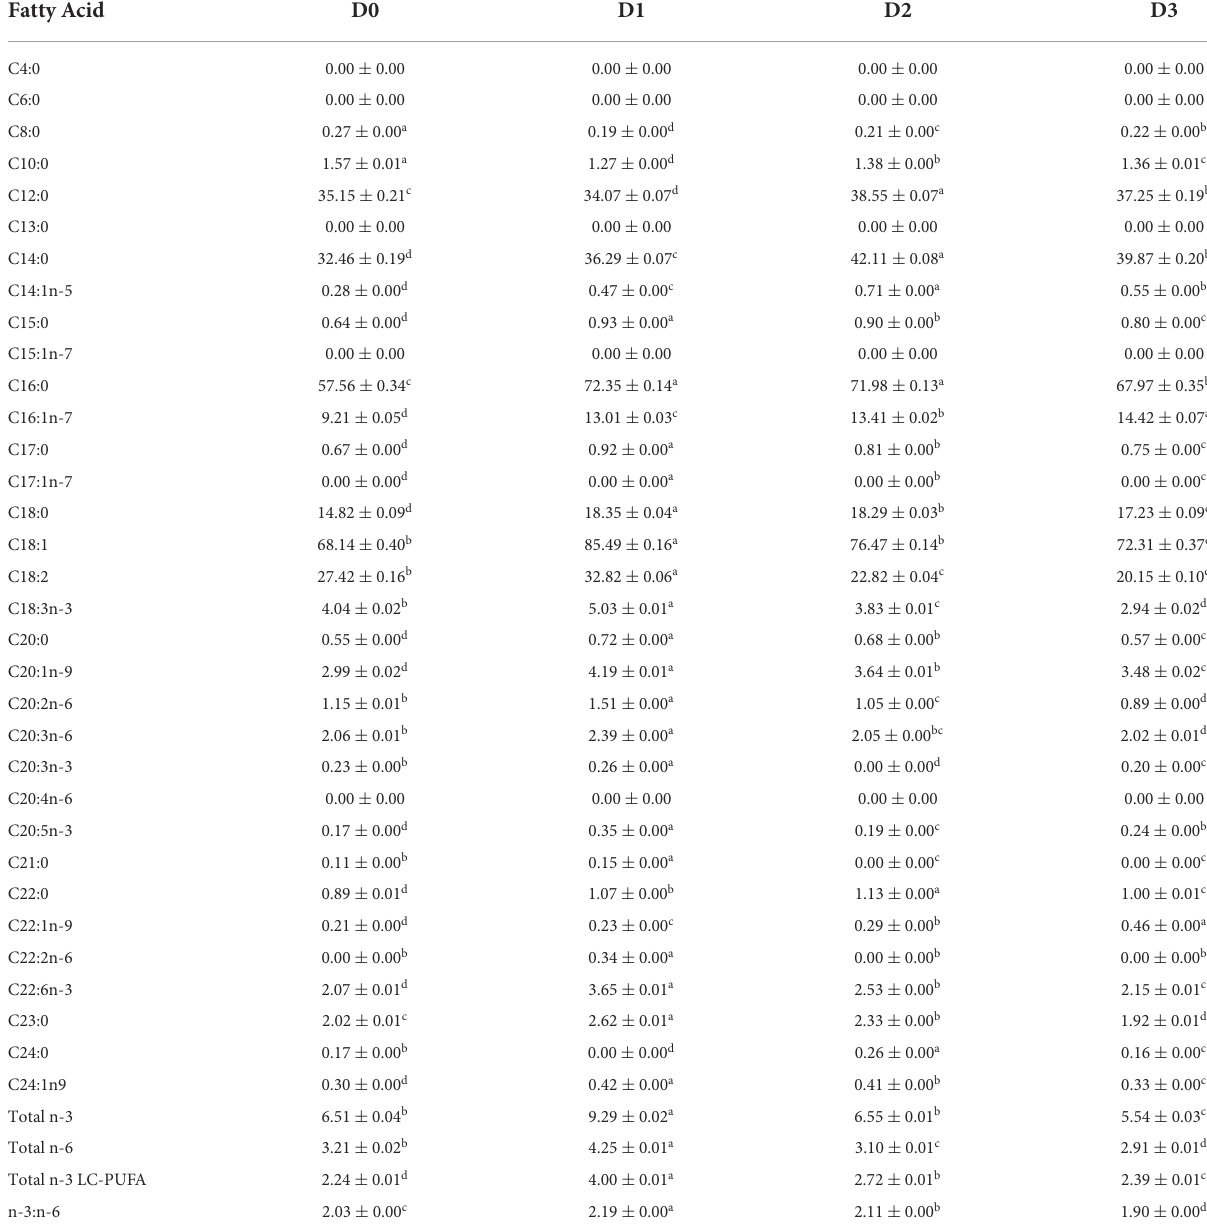
TABLE 6 Fatty acid composition (mg/g tissue) of seawater-tolerant tilapia fed with diets supplemented with T. weissflogii